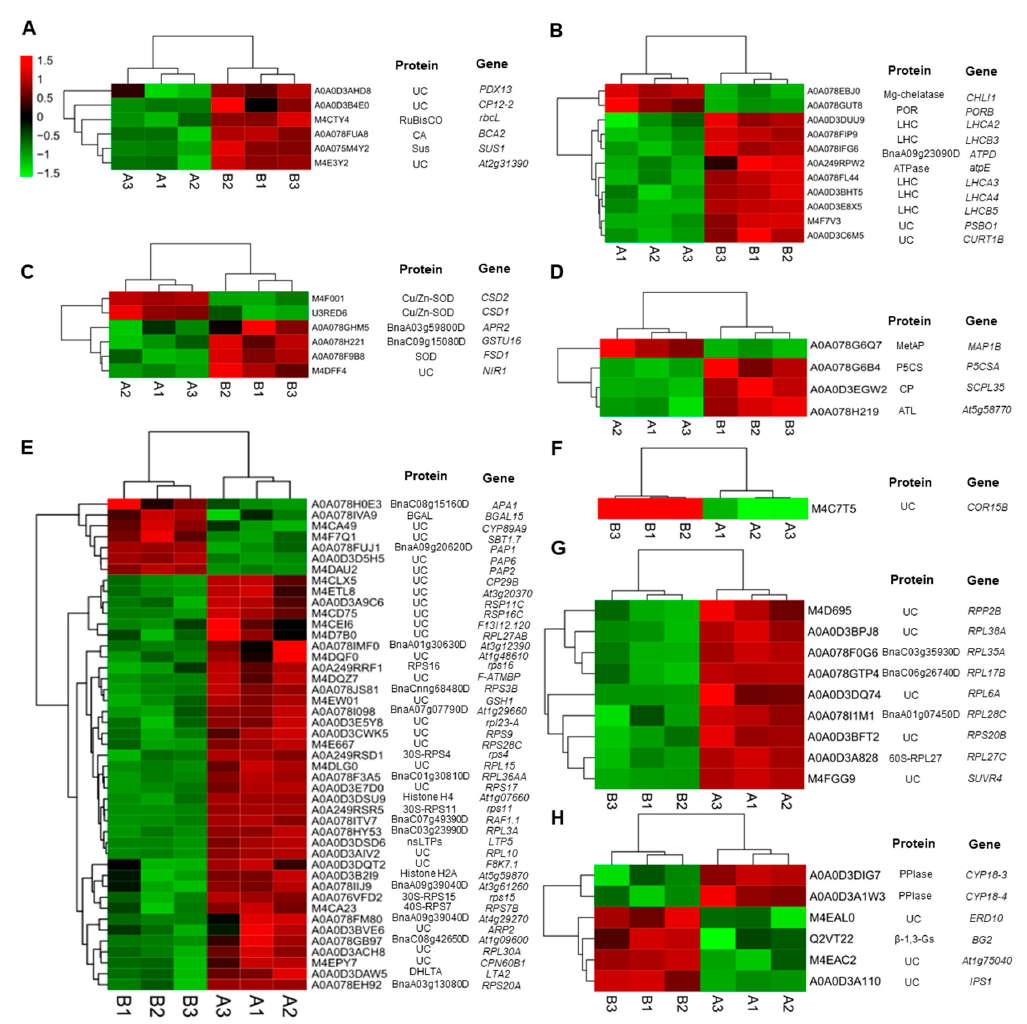
Figure 4. Heatmap of the 89 identified differentially expressed proteins (DEPs) at low temperatures (B1, B2, and B3) compared to the control (A1, A2, and A3). These proteins were classified into carbohydrate metabolism ( A ), photosynthesis and energy metabolism ( B ), oxidative defense ( C